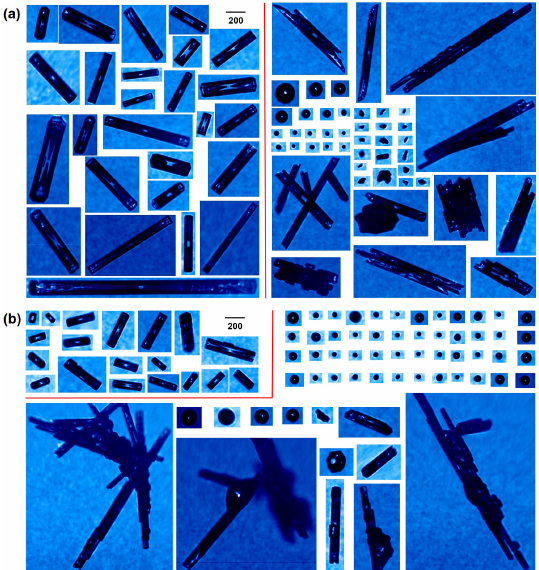
Figure 6. Examples of cloud particles imaged by CPI in mixed- phase clouds (a) between 17:39:45–17:50:43 and 21:09:39– 21:11:25UTC on 16 April 2010 (SPARTICUS) at − 8 . 0 < T < − 2 . 4 ◦ C and (b) between 19:59:30 and 20:00:16UTC on 4 April 2008 (ISDAC) at − 2 . 6 < T < − 1 . 9 ◦ C. In each panel, measured columns (left) and other particles (right) are divided with a red line. A 200µm scale bar is embedded in each